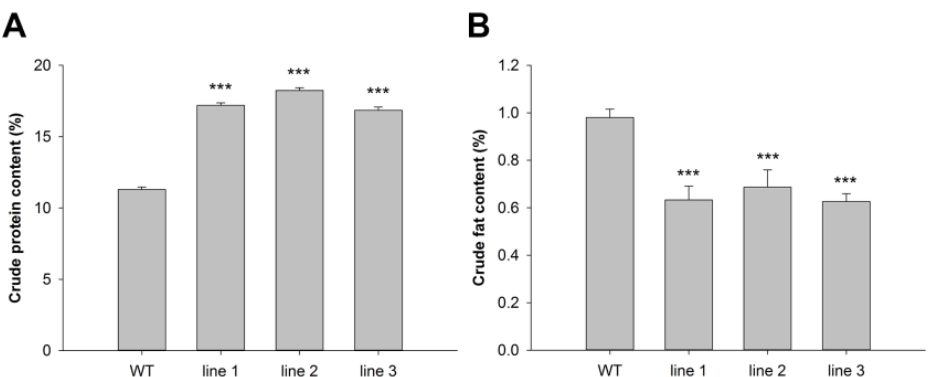
Figure 7. Crude protein and crude fat contents of WT and transgenic alfalfa. ( A ) The crude protein content of WT and transgenic alfalfa. ( B ) The crude fat content of WT and transgenic alfalfa. Data were expressed as mean ± SE (n ≥ 6). WT: wild-type alfalfa; line 1, 2, 3: transgenic alfalfa. *** indicates a statistically significant difference at p < 0.001.